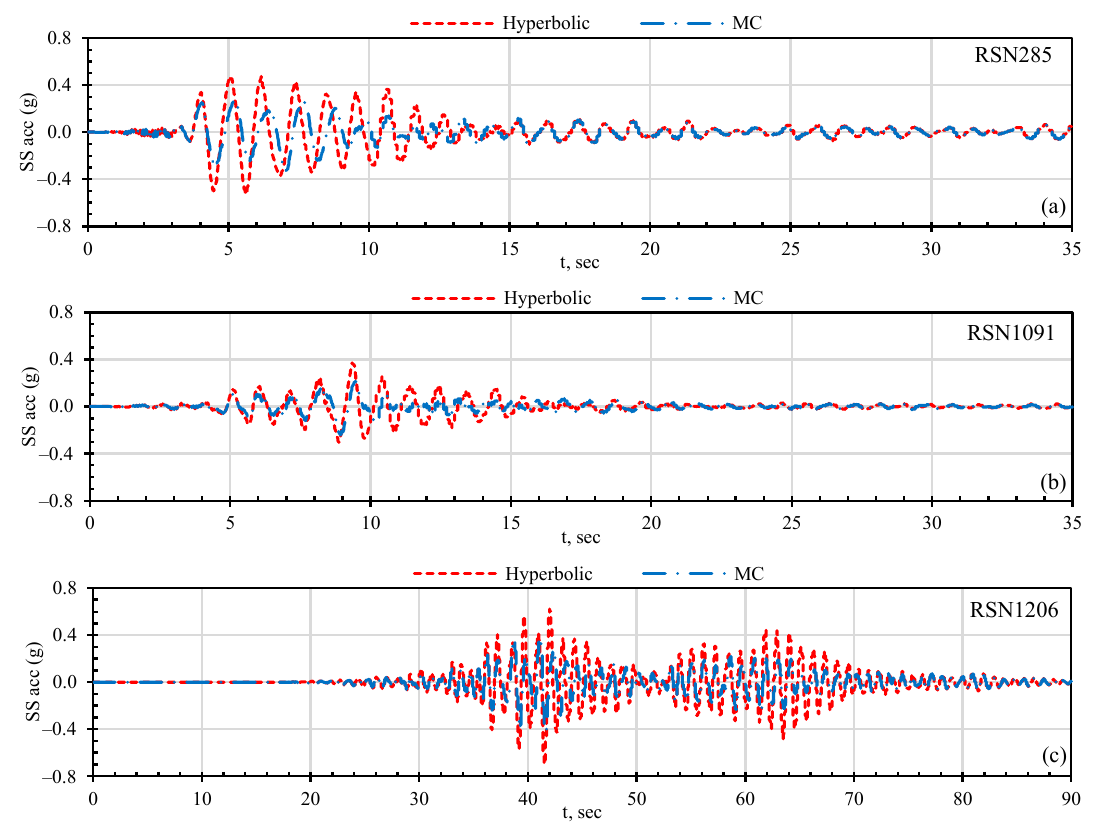
RSN572, ( c ) RSN1613. ( b )